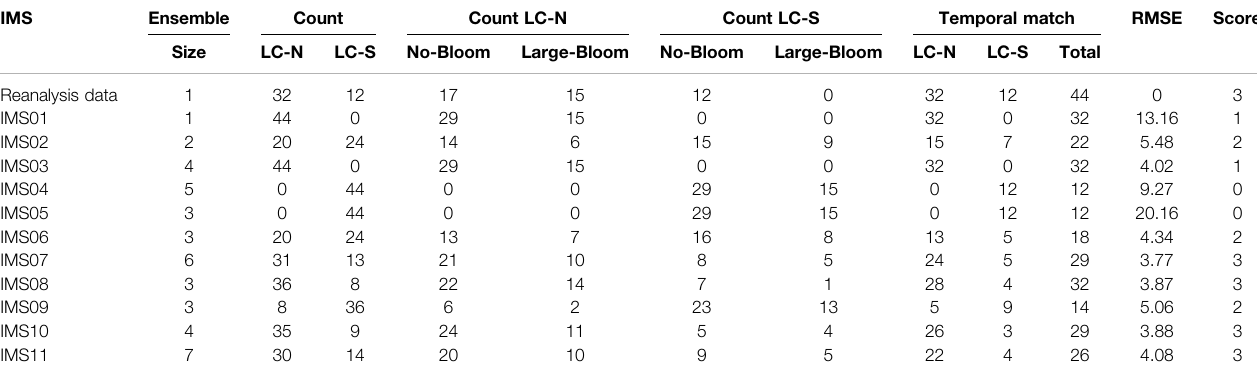
TABLE2| RawdataofLoopCurrentatNorth(LC-N)andSouth(LC-S)positions,andtheirrelationtotheoccurrenceoflargebloomsforreanalysisdata,andeachensemble member (i.e., independent model subset, IMS). The ensemble size is the number of model runs per ensemble member, and the reanalysis data has only one realization. Note given Score ( y 1 , y 2 , y 3 ) the model receives a score from 0 to 3 for Score (0, 0, 0), Score (1,0,0), Score (1, 1, 0), and Score (1, 1, 1), respectively. IMS